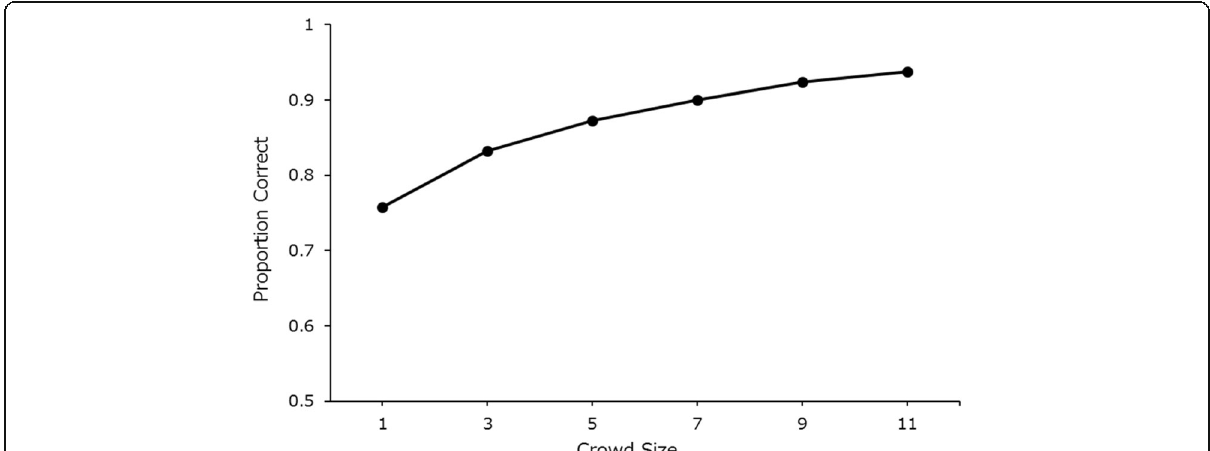
Fig. 11 Mean face-search accuracy as a function of crowd size. As each point represents the average performance of 24,000 randomly sampled groups of participants (1000 groups per target identity), standard error bars (mean standard error = 0.002) would lie within the marker point and are therefore not represented on the